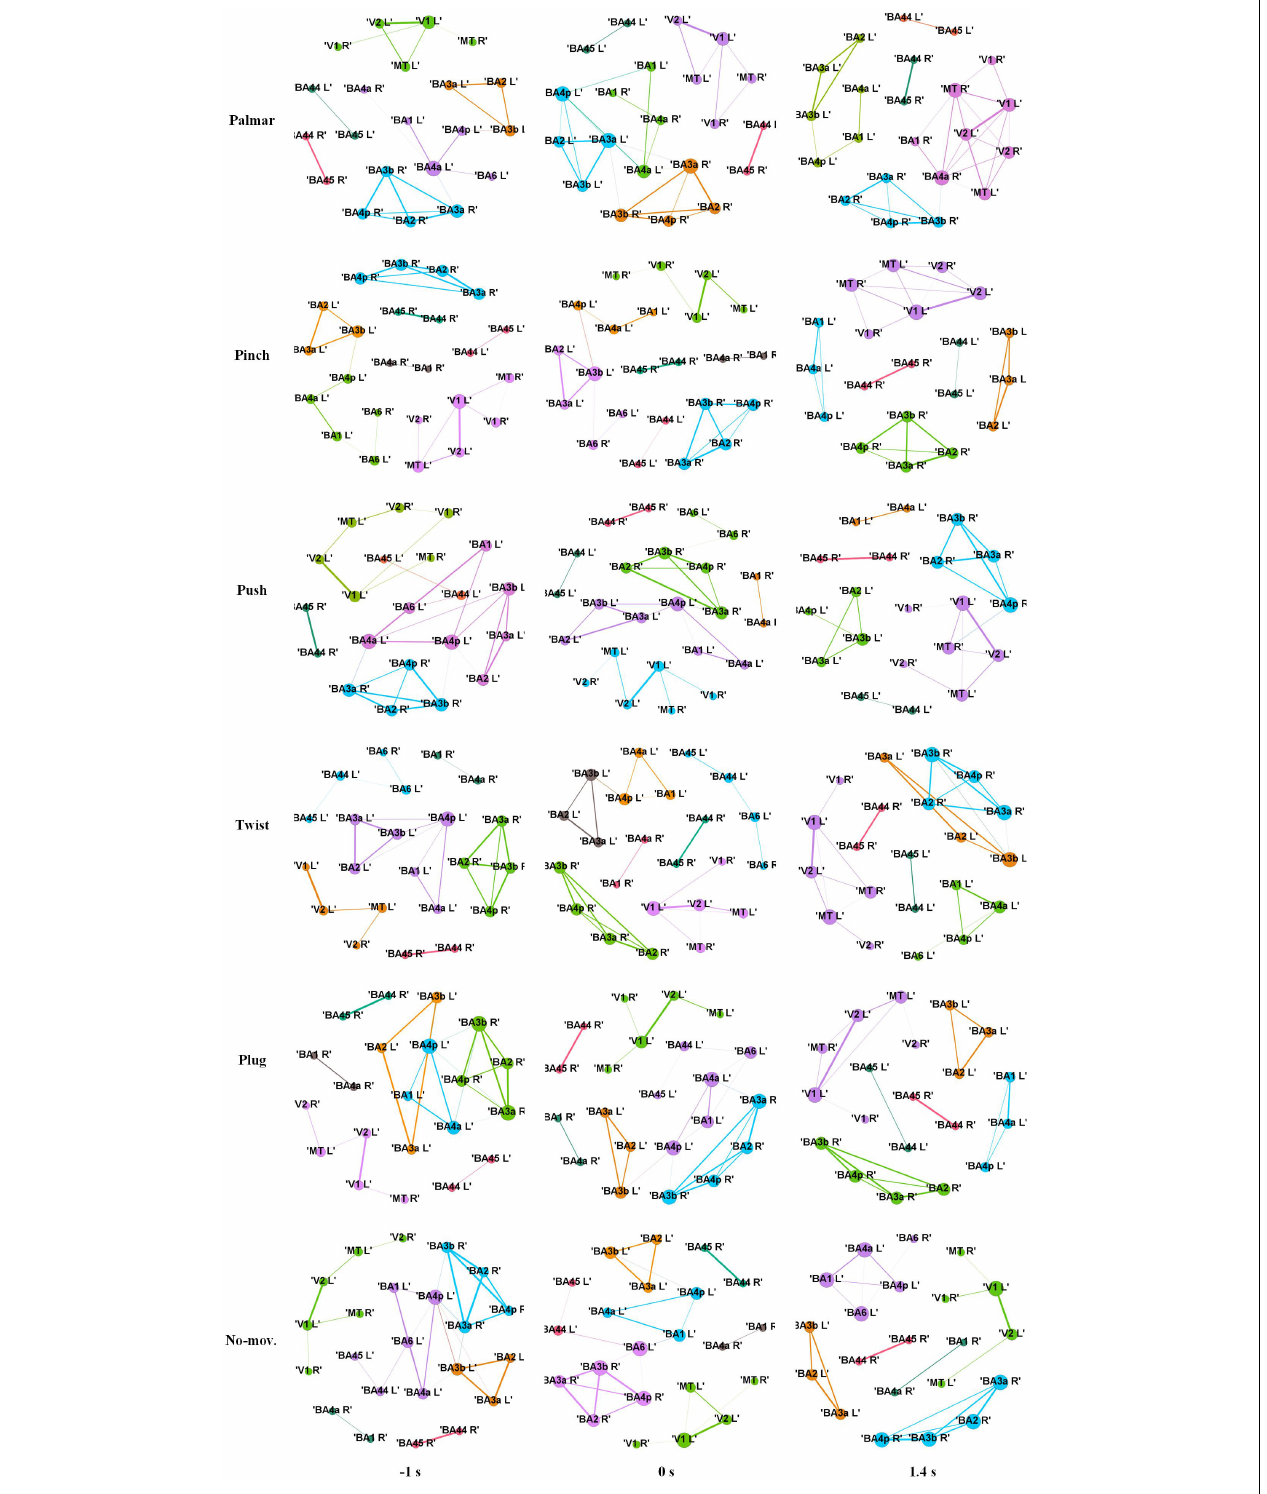
FIGURE 8 | Functional connectivity maps of S2 for each condition. The size of a node indicates DE of the node. The width of an edge indicates the weight of the edge. The edges whose weight is less than 0.65 are filtered. Different colors indicate different modules. Each column represents network structure at different time points, which from left to right are − 1, 0, and 1.4 s,